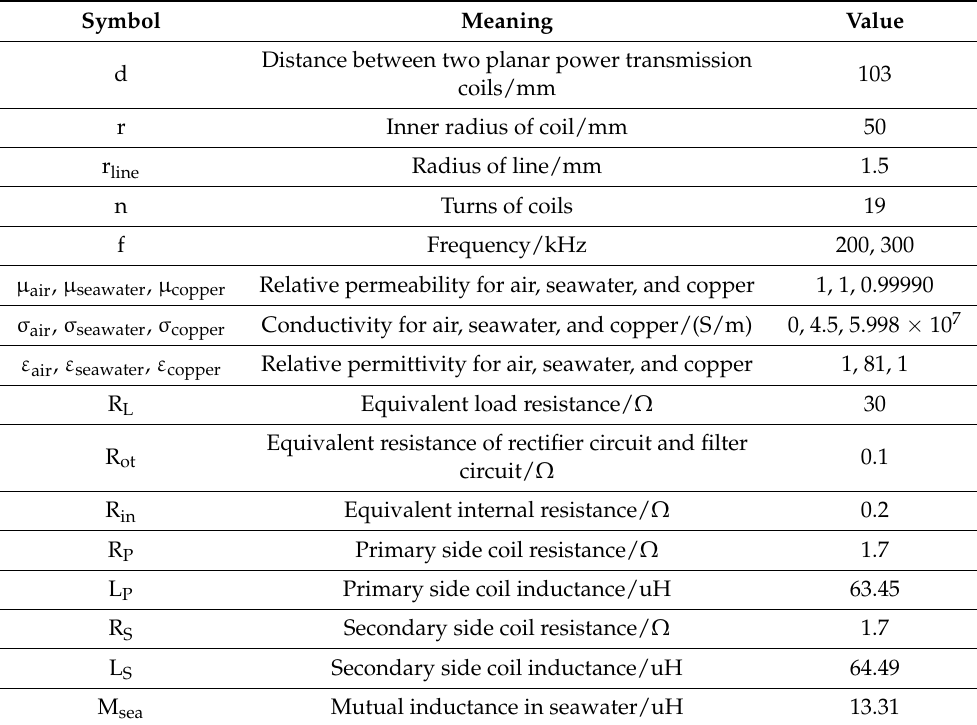
Table 1. The meanings and value of parameters in